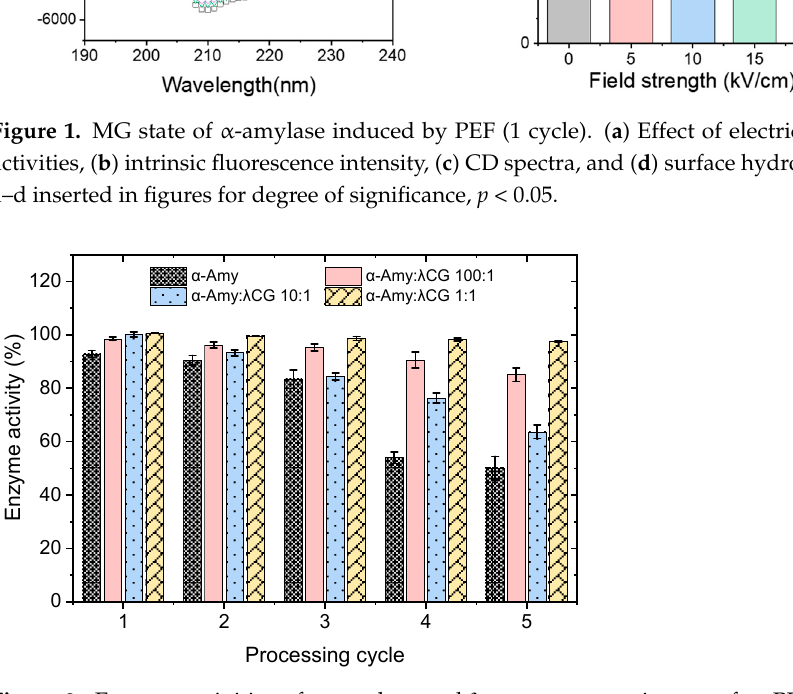
Figure 2. Enzyme activities of α -amylase and λ -carrageenan mixtures after PEF treatment with 0–5 cycles.